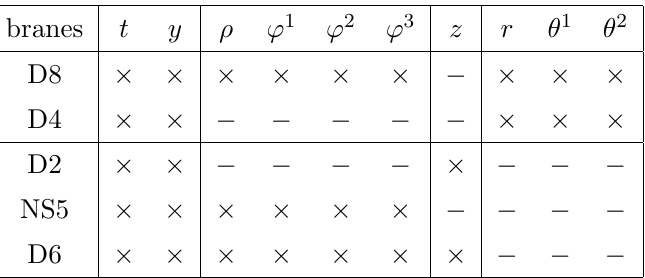
Table 4 . The brane picture underlying the N = (0 ; 4) SCFT 2 defect theory described by D2-NS5- D6 branes ending on an D4-D8 intersection. The system is BPS =